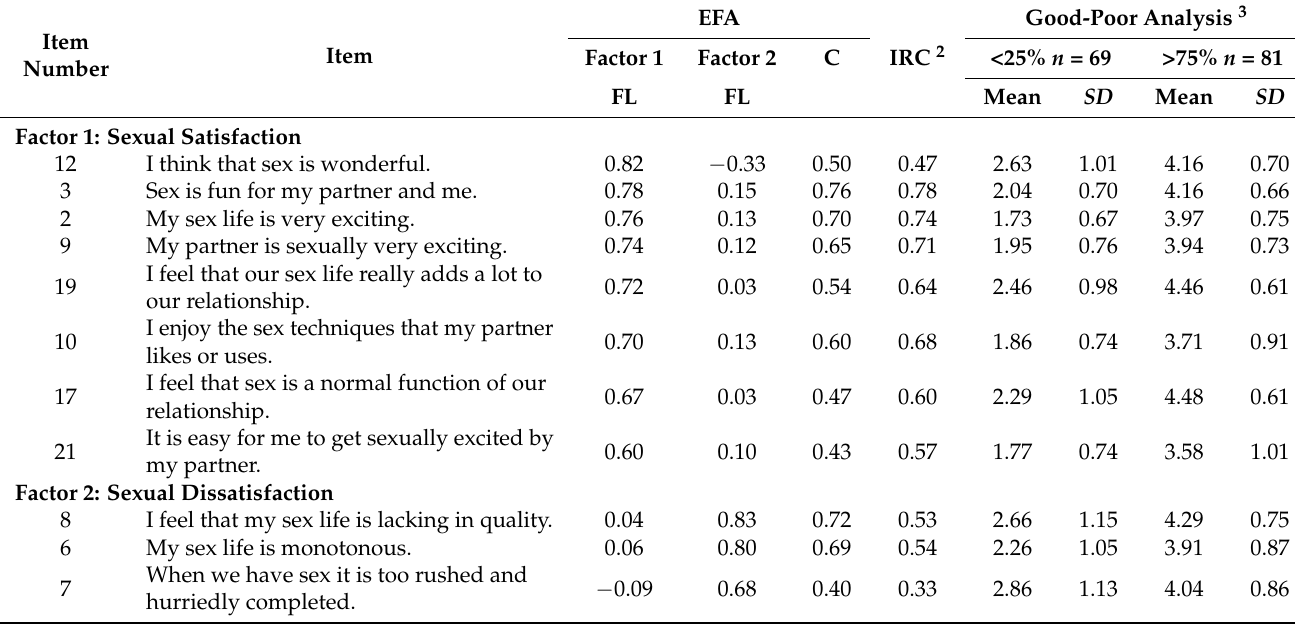
Table 2. Exploratory factor analysis and reliability estimates of the revised Japanese version of the ISS (N = 294 1 ).